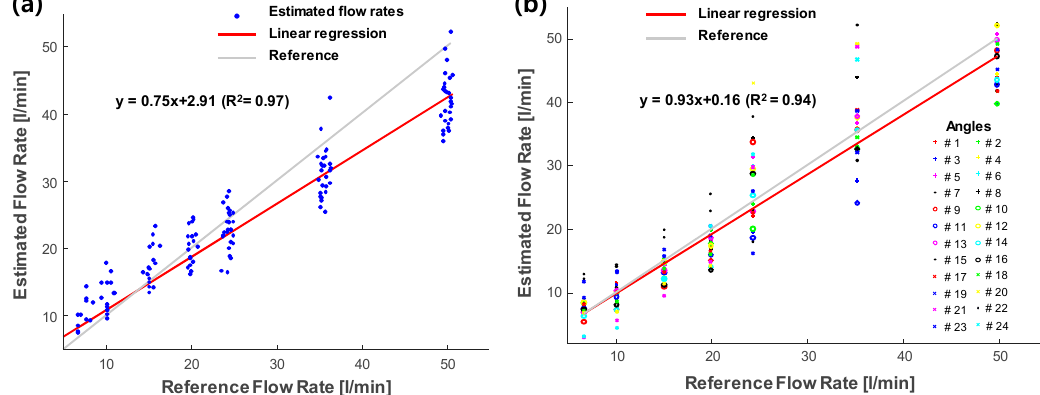
Figure 10. Estimated flow rates using ( a ) a single plane wave and ( b ) multiple angular compensation.